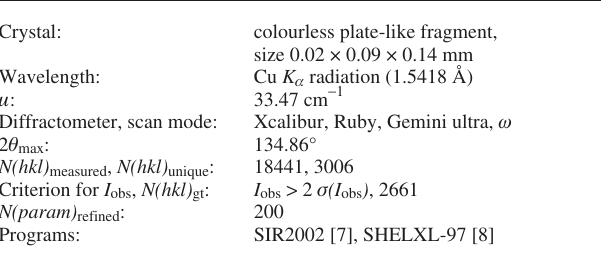
Table 1. Data collection and handling.